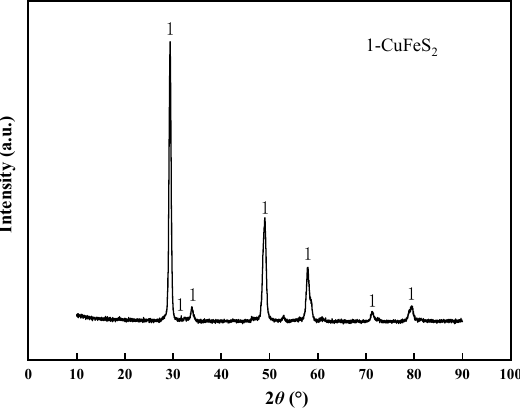
Figure 1. XRD test result of chalcopyrite sample.